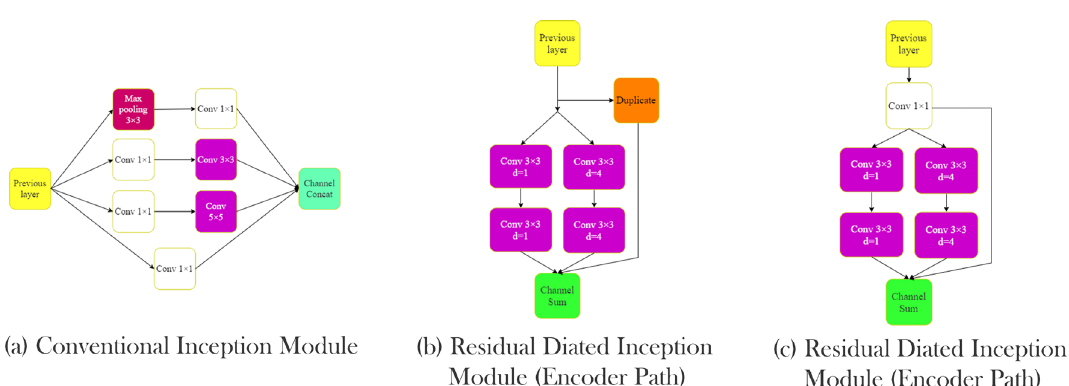
Figure 4. Inception modules. Comparison of conventional and proposed inception module ( a ) conventional inception module, ( b ) residual dilated inception module (encoder path), ( c ) residual dilated inception module (decoder